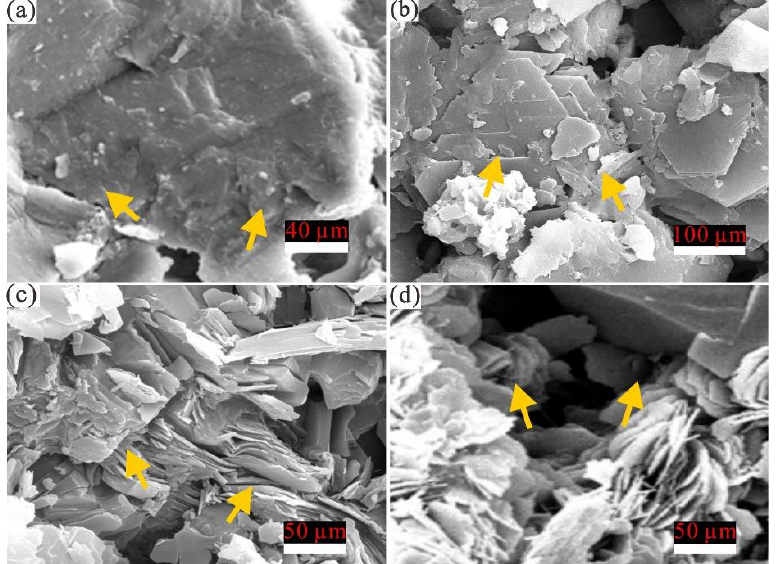
Figure 8. Diagenetic characteristics of the Ahe reservoir shown under the SEM. ( a ) Calcite cement (Well YN2, 4841.63 m); ( b ) Kaolinite cement (Well DX1, 4855.45 m); ( c ) Illite cement (Well YN5, 4930.58 m); ( d ) Chlorite cement (Well DX1, 4856.85 m). 4930.58 m); ( d ) Chlorite cement (Well DX1, 4856.85